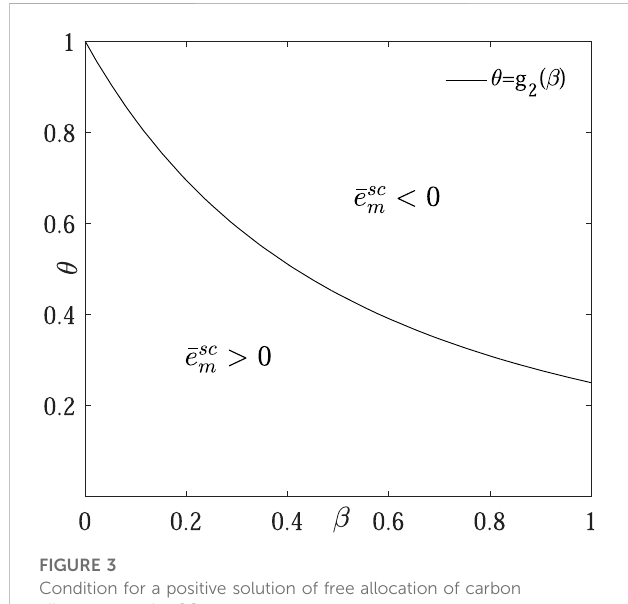
FIGURE 3 Condition for a positive solution of free allocation of carbon allowance under